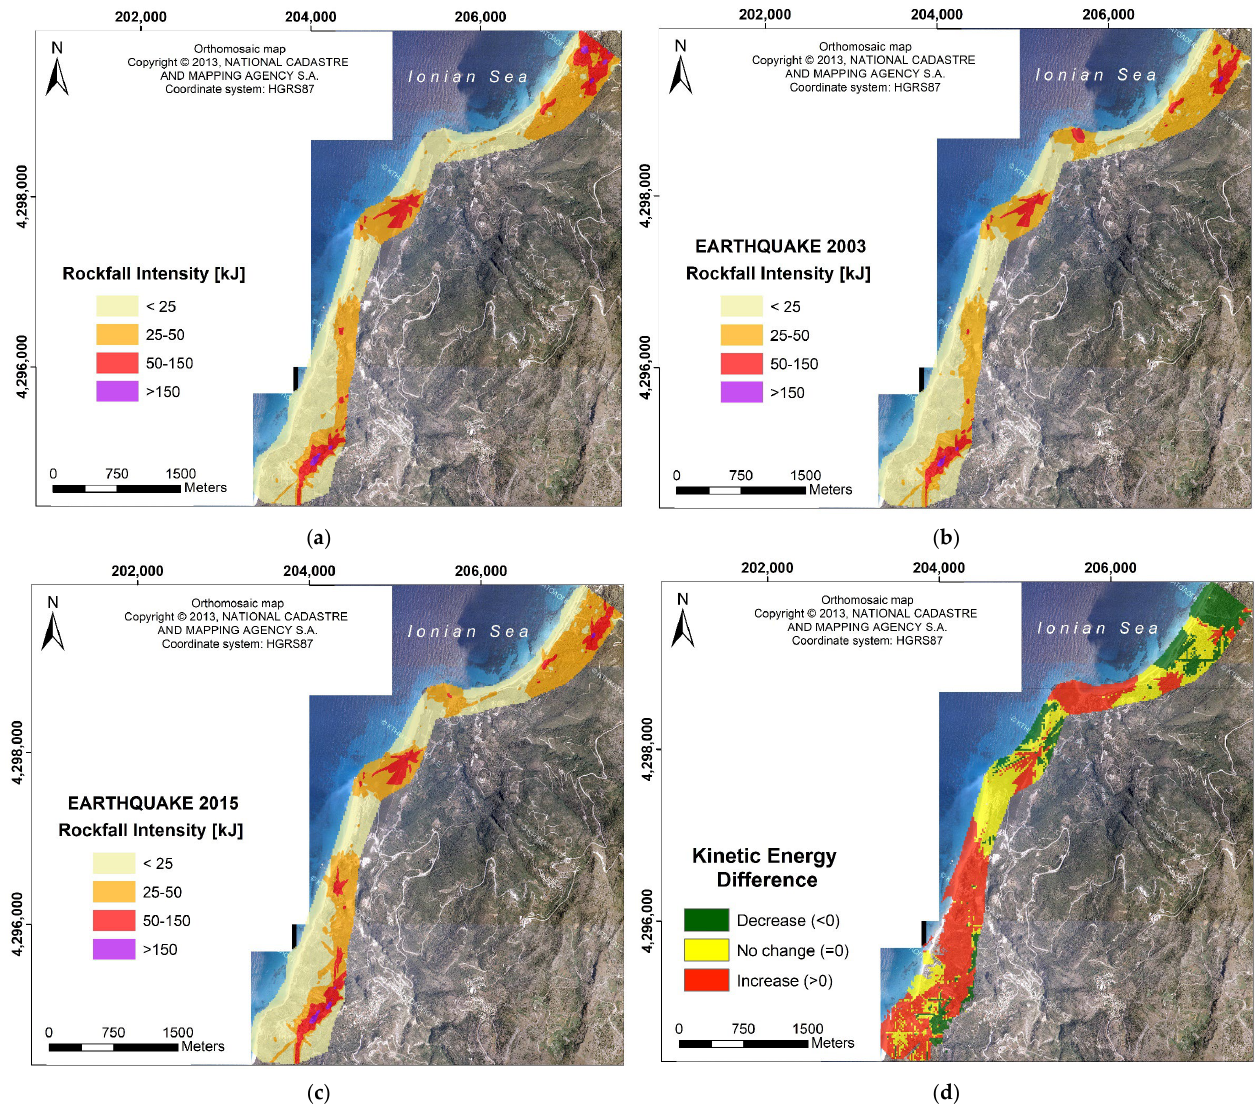
Figure 11. Rockfall intensity maps of area B, with ( a ) Vo = 0, ( b ) Vo = 0.69 m/s, ( c ) Vo = 0.72 m/s, and ( d ) difference in the kinetic energy distribution between ( a and c ).